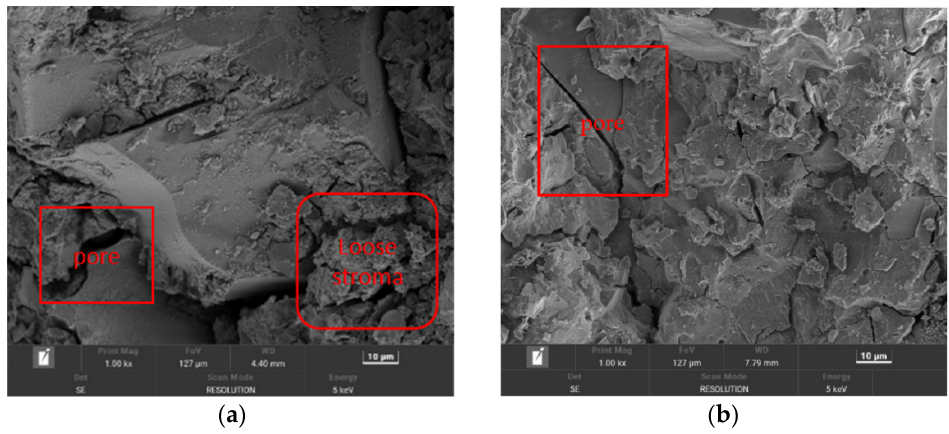
Figure 20. SEM images of RPSG with different slag contents [68,75]; ( a ) RP-S0- M1.3N6 (1000×); ( b ) RP-S30- M1.3N6 (1000×). ( b ) RP-S30- M1.3N6 (1000 ×